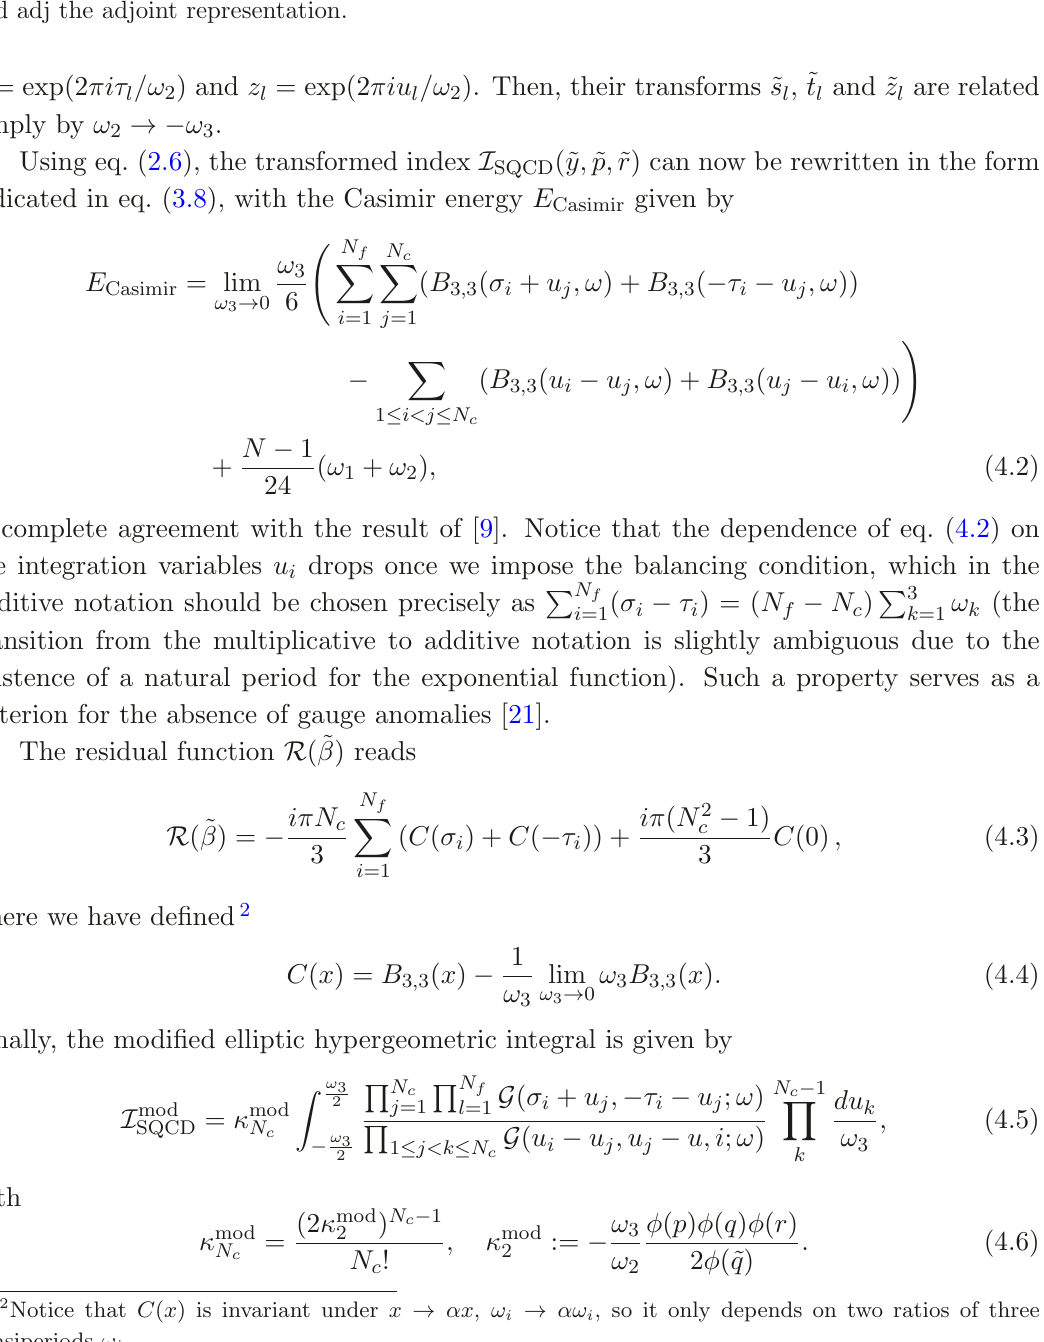
= 1 SQCD. f denotes the fundamental, ¯ f the antifundamental N